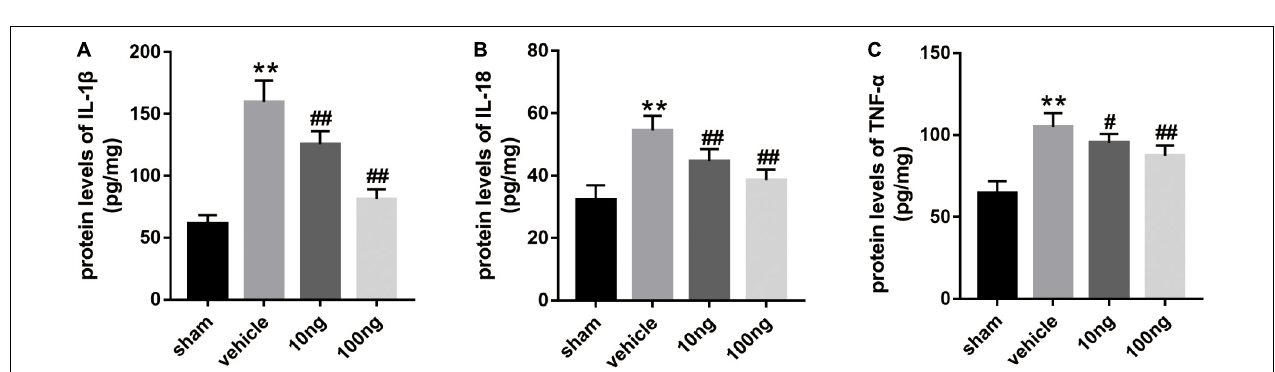
FIGURE 2 | MaR1 decreased the spinal cord’s proinflammatory protein levels ( n = 6/group). ELISA was employed to measure the inflammatory cytokines’ protein levels. (A–C) MaR1 (10 or 100 ng) reversed the rising protein levels of IL-1 β , IL-18, and TNF- α induced by NCLDH. Data are presented as the mean ± SD (** P < 0.01 versus the sham group; ## P < 0.001 versus the vehicle group; # P < 0.05 versus the vehicle group).